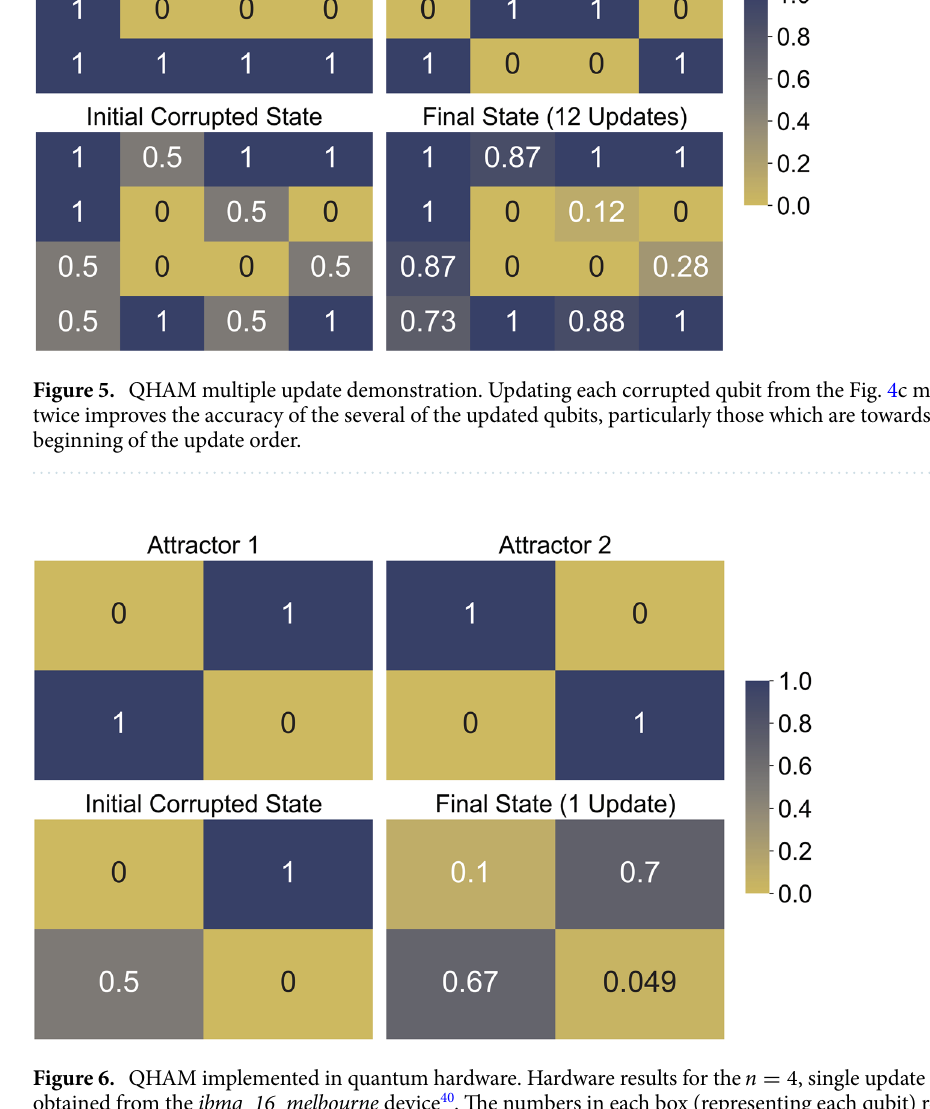
1 for each qubit. Two attractors are given and an initial state with | �